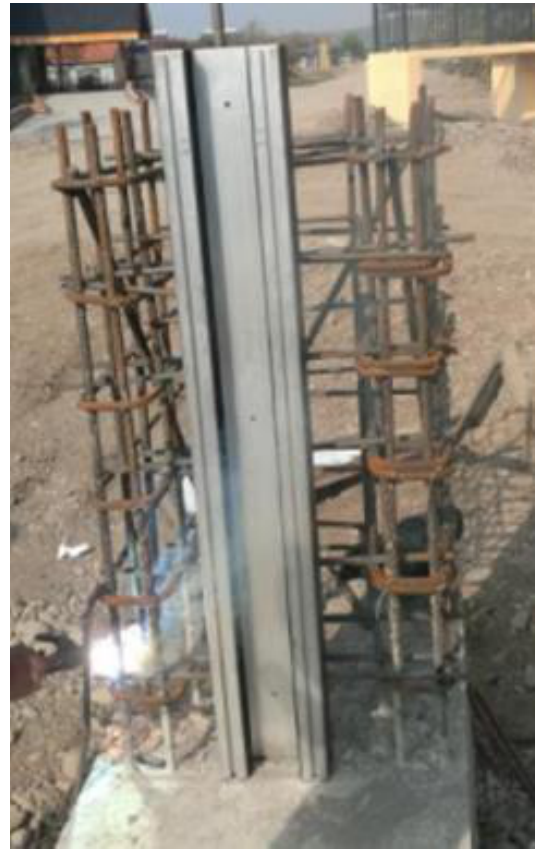
Figure 14. End post welded to the reinforcement.